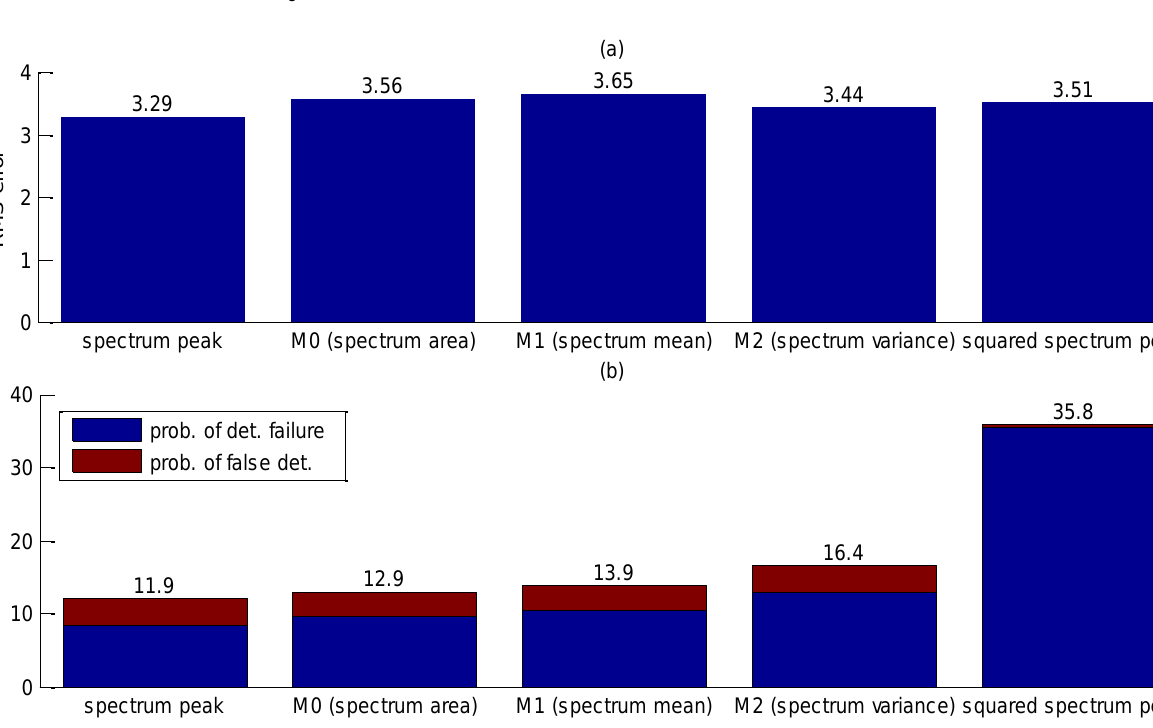
Figure 13. Accuracy performance results for selected shape parameters. ( a ) RMS error results. ( b ) Probability of false detection and detection failure